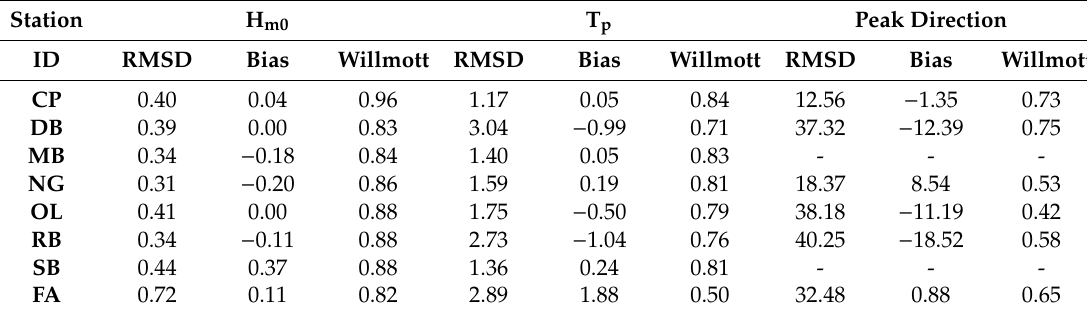
Table A3. Model performance statistics per coastal buoy location for JJA 2017, M3.